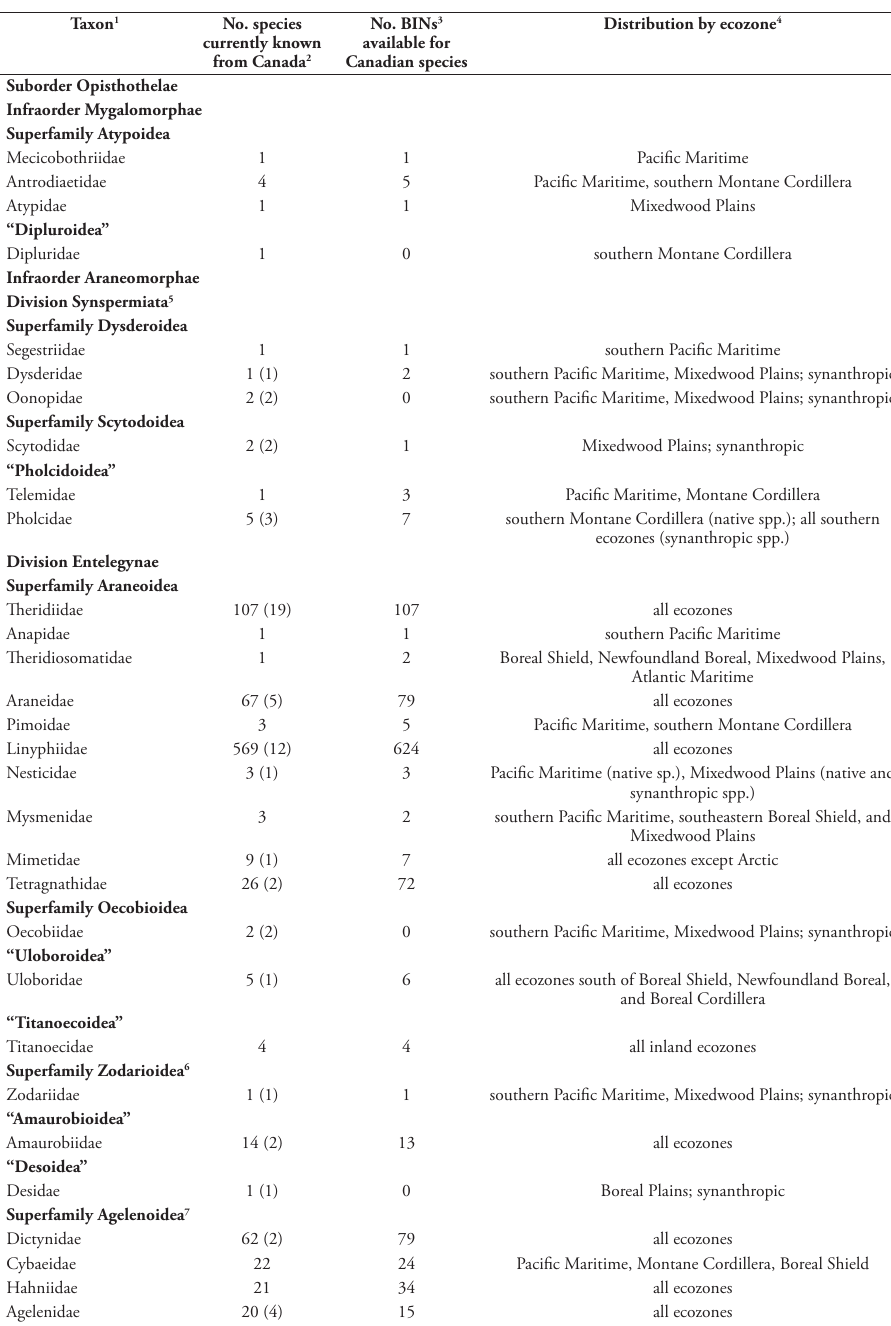
Table 1. Census of Araneae in Canada. Data as of March 2018 (R Bennett and G Blagoev unpubl. data). Primary references for all family-level and lower taxa are in the World Spider Catalog (2018) and Ubick et al.